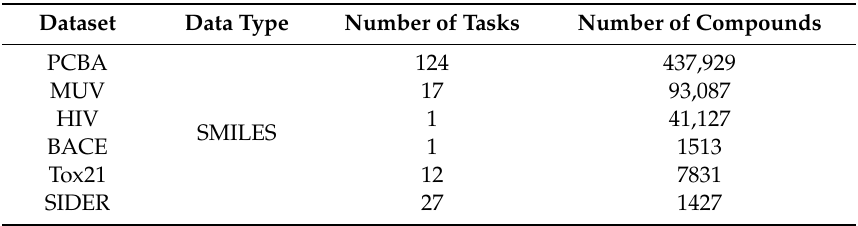
Table 1. Source data information.